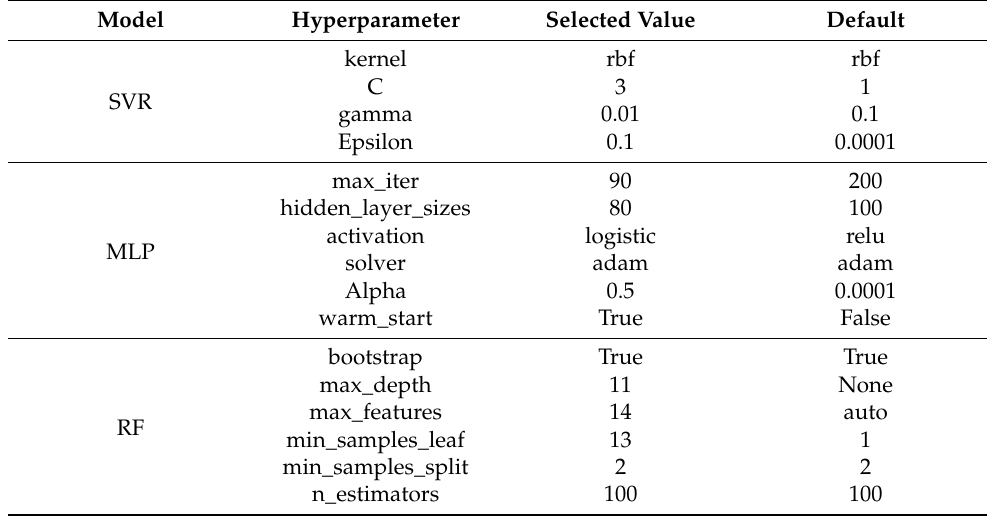
Table 4. Hyperparameters tested in GridSearchCV and those applied to each ML